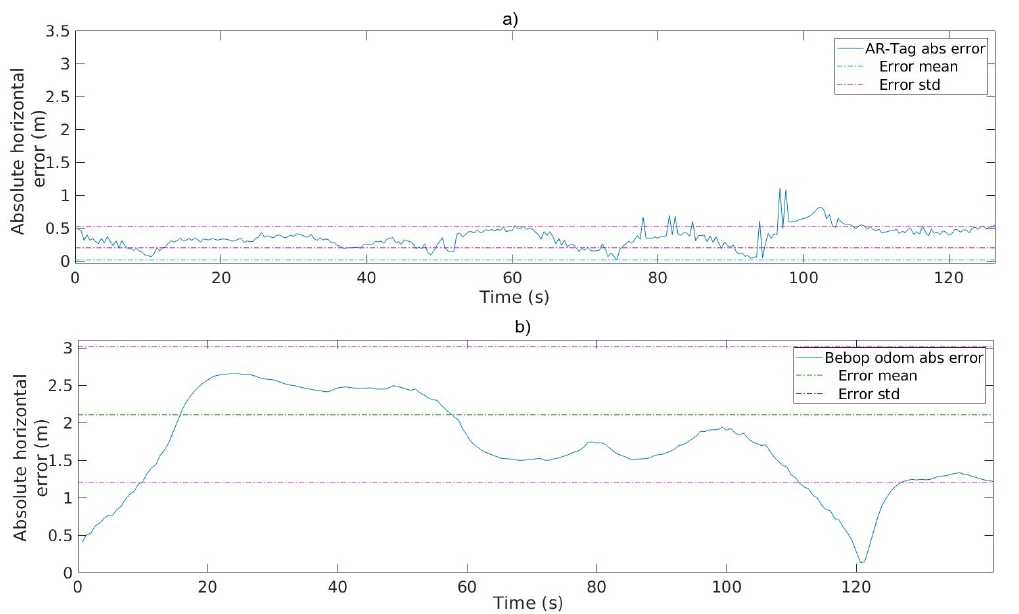
Figure 10. Absolute horizontal error for the AR-Tag and Bebop odometry with the mean and standard deviation values. ( a ) AR-Tag absolute error statistics; ( b ) Bebop odometry error